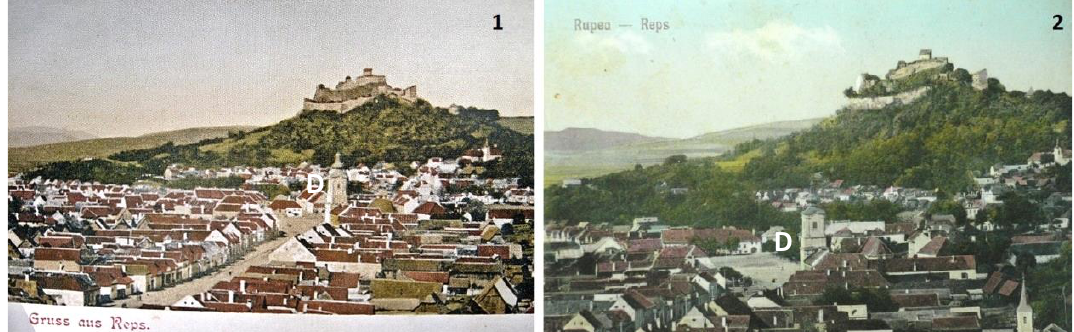
Figure 6: Two bird’s eye view postcards on Reps-Rupea showing by comparison a few changes before and after the First World War, images taken before 1925 1 – Postcard with the main street of Reps (Rupea) after 1910 (Borcoman,